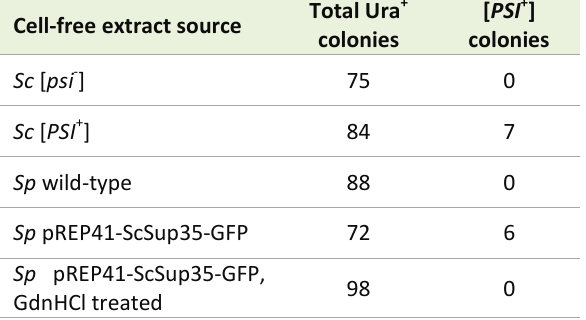
TABLE 1. Number of [ PSI + ] Ura + S. cerevisiae colonies after transformation with cell-free extracts prepared from different species and strains as indicated.